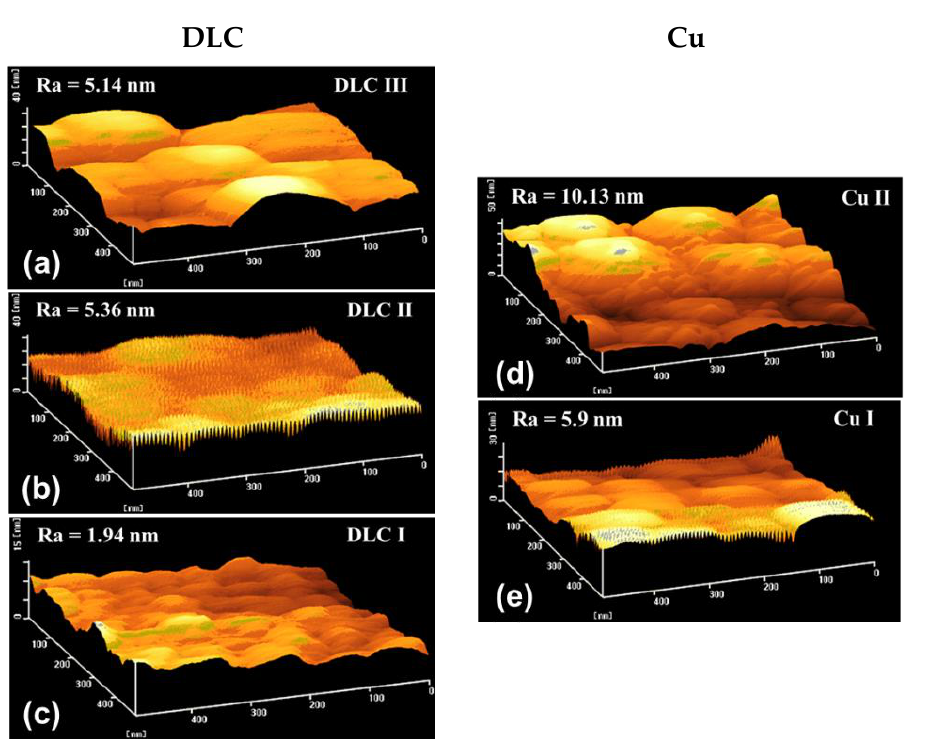
Figure 7. Surface shapes and roughness of the ( a ) DLC III, ( b ) Cu II, ( c ) DLC II, ( d ) Cu I, and ( e ) DLC I films for the samples in group C. Table 3. Roughness and thickness of the films for the samples in group C.